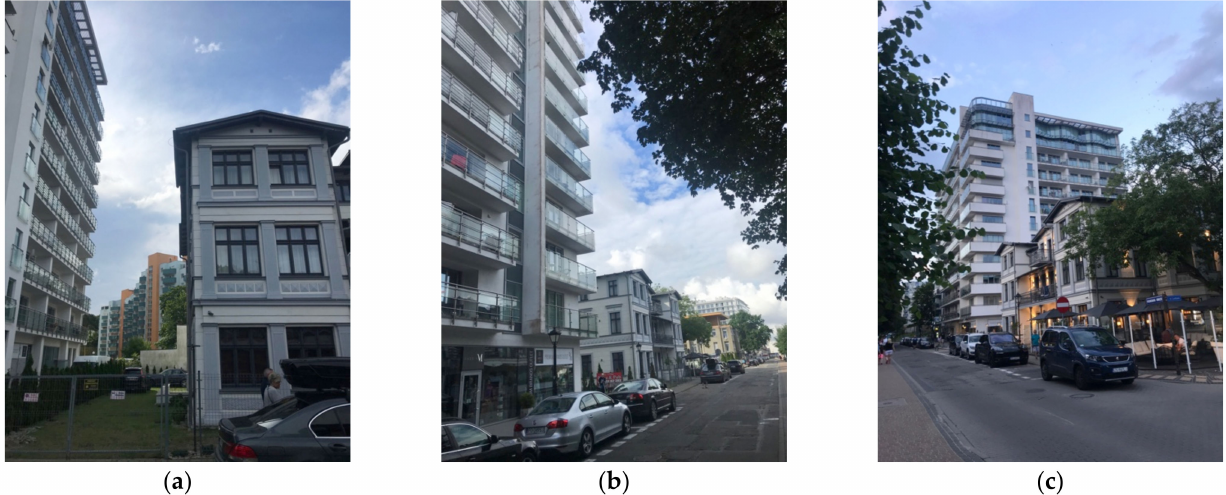
Figure 6. Mi˛edzyzdroje. Contrast of old and new buildings: changing the scale of buildings and the way of rest ( a – c ). Source: Author’s photo ( a – c ).